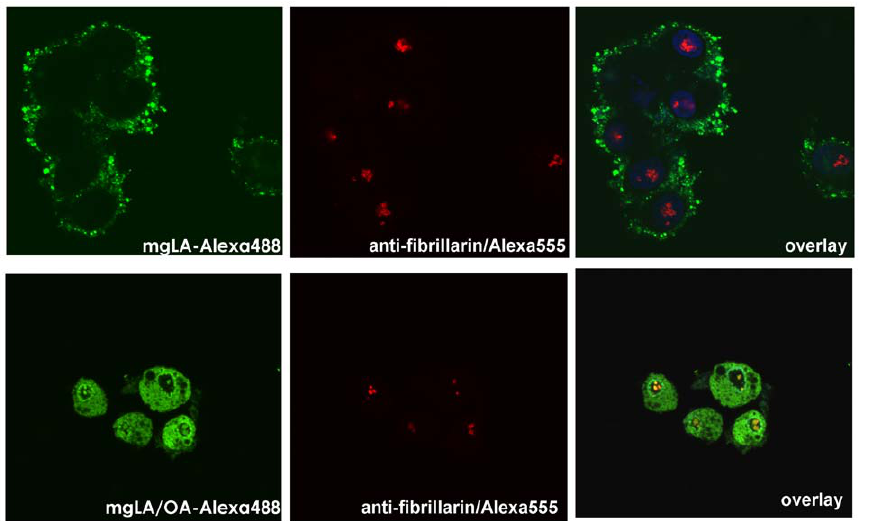
Figure 9. Aggregates in the nuclei co-localize with a nucleolus marker. SK-BR-3 cells were treated with Alexa Fluor 488 labeled mg-hLA-ext complexed with OA or without OA (control) for 4 h, fixed, permeabilized, incubated with a-fibrillarin monoclonal antibody, and detected with anti- mouse-Alexa Fluor 555–labeled antibody (red). In cells treated with OA complex, co-localization of green fluorescent signal and fibrillarin protein was found at the cell nuclei in SK-BR-3 and MDA-MD-468 (data not shown) cell lines.